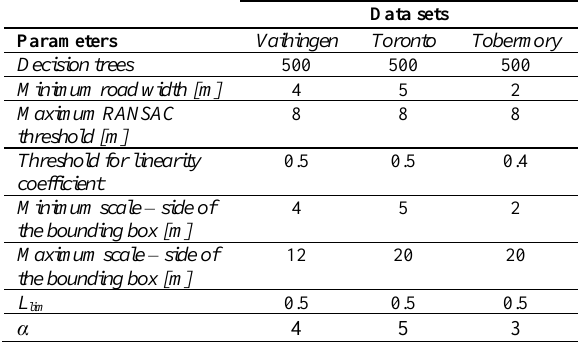
Table 1. Parameters used for the processing of the different data set.